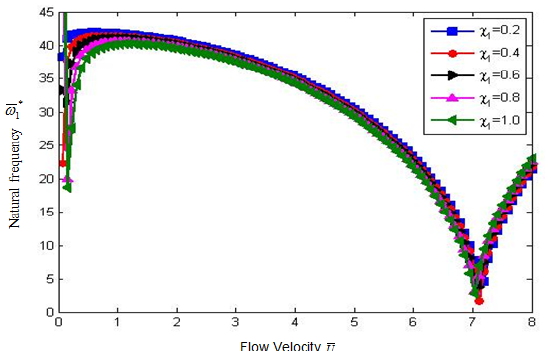
Figure 9. Absolute values of the transverse natural frequencies ¯ ω 1 ∗ profile for the case R i = 0 . 41 m,L = 2 km,γ = 0 . 02 ,δ 1 = 0 . 3721 , Θ = 100 ◦ C